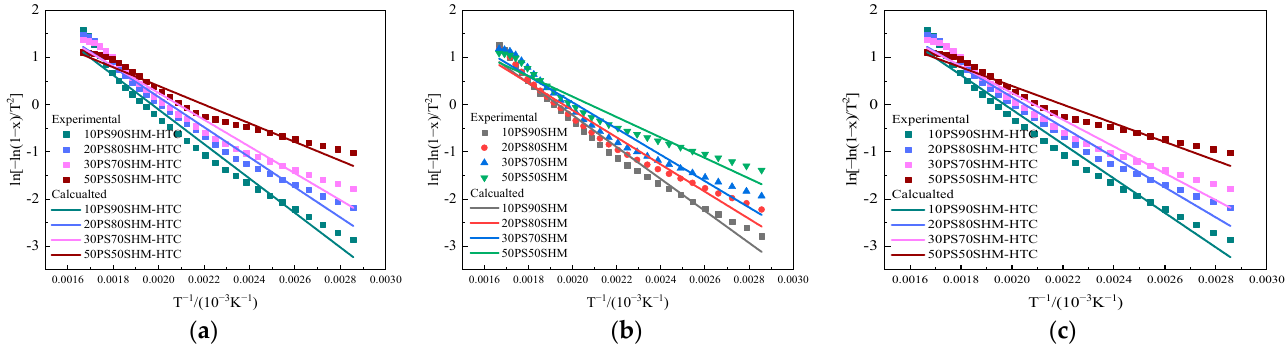
Figure 6. Fitting curves using the Coats–Redfern method of: ( a ) PS; ( b ) SHM; ( c ) SHM-HTC and their blends.